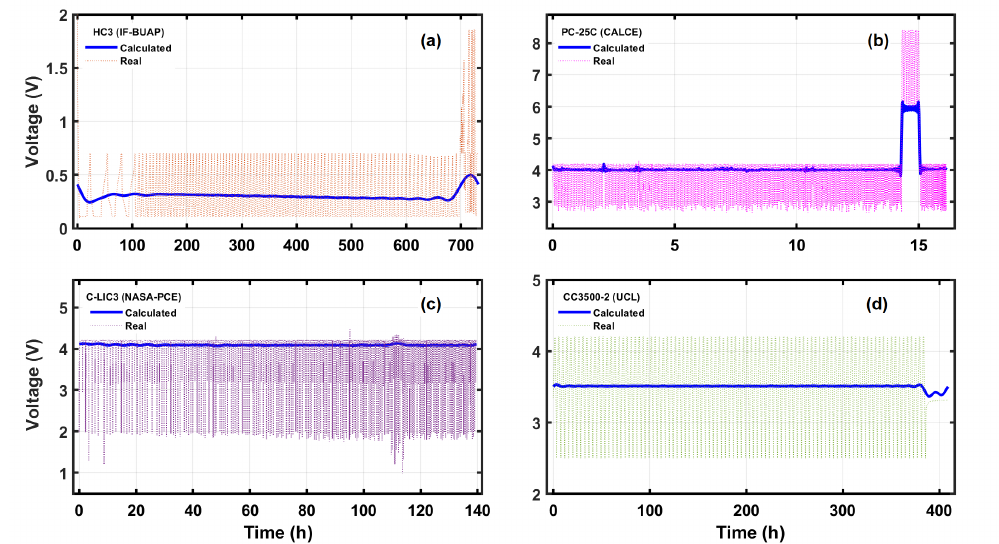
Figure 7. Real vs. calculated voltage by applying the inverse Fourier transform to the high periods found by wavelet to ( a ) HC3 half-cell IF-BUAP, ( b ) PC-25C cell–CALCE, ( c ) C-LIC3 cell–NASA-PCE and ( d ) CC3500–2